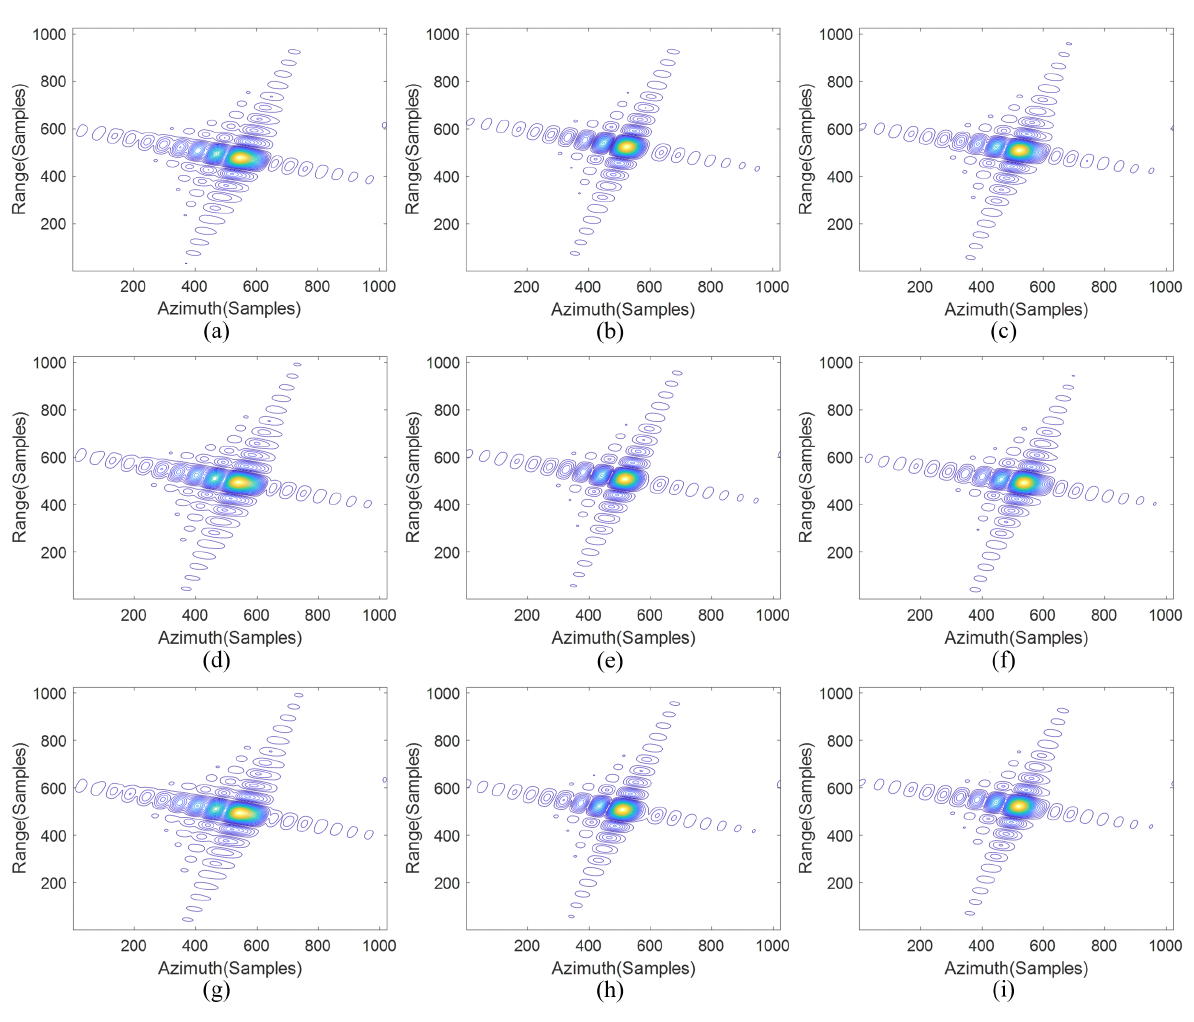
Figure 5. Real-time imaging results of typical OSA with the traditional squint hyperbolic model. ( a – c ) Results of targets 1–3. ( d – f ) Results of targets 4–6. ( g – i ) Results of targets